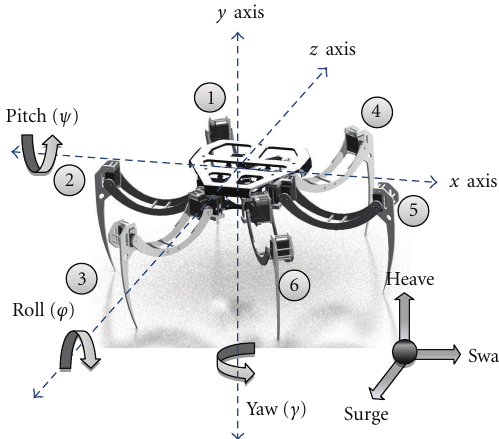
Figure 1: Pro engineer model of hexapod robot.